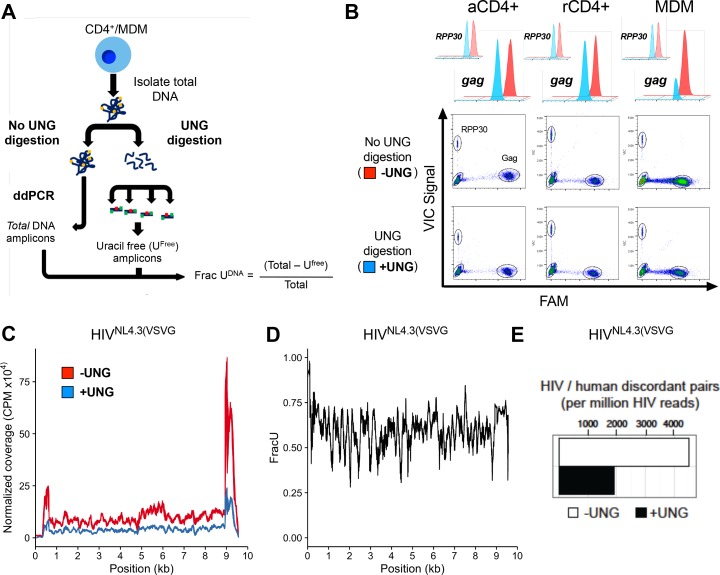
Ex-ddPCR and Ex-Seq determine the uracil content of the HIV DNA copies.(A) After infection of immune cells with the single-round VSV-G pseudo-typed virus HIVNL4.3(VSVG), total DNA is isolated and either digested by UNG to degrade uracil containing DNA or mock digested to provide a measure of total amplifiable DNA in the sample. The output (Frac UDNA) represents the fraction of amplified DNA copies containing at least one uracil on each DNA strand. Signal is normalized to a genomic reference copy standard (RPP30) that does not contain uracil. (B) Activated, resting CD4+ T cells and MDMs were infected in vitro with HIVNL4.3(VSVG) virus and the uracil content was measured 3 days post-infection (dpi) using primers that targeted the gag region. The data (± UNG digestion) are shown as scatter plots and histograms. (C) Normalized coverage of the HIVNL4.3(VSVG)-genome-positive strand in Excision-Seq (Ex-Seq) libraries prepared from total cellular DNA at 7 days post-HIV infection. (D) Fraction of the reads in panel C that contained uracil (Frac U). (E) Discordant read pairs between HIV and human DNA present in Ex-Seq libraries prepared from total cellular DNA at 7 days post-infection with HIVNL4.3(VSVG) virus. The number of discordant reads obtained by Ex-Seq in the absence and presence of UNG digestion are shown as white and black bars.